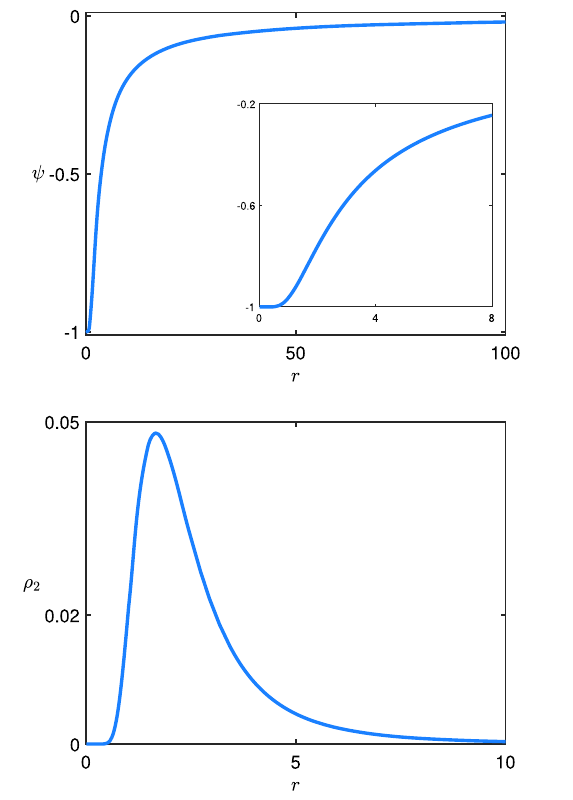
Fig. 14 The solution ψ( r ) in Eq. (55) (top) and the energy density ρ 2 in Eq. (56) (bottom) for α = 2. The inset in the top figure shows the solution near the origin